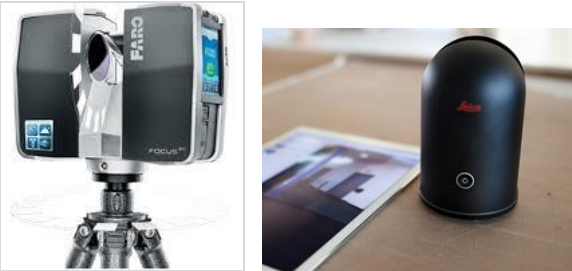
Figure 1. Examples of laser scanners (terrestrial laser scanner FARO, Leica BLK360).